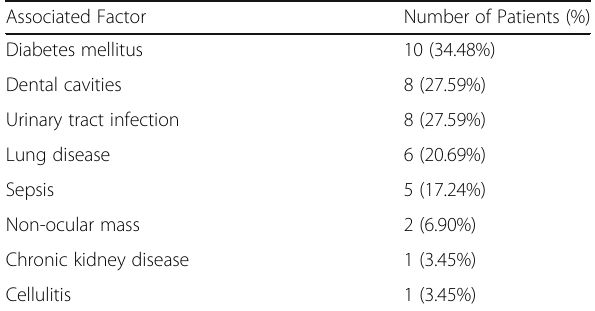
Table 5 Identified risk factors for endogenous endophthalmitis ( n = 29). Diabetes mellitus, dental cavities, and urinary